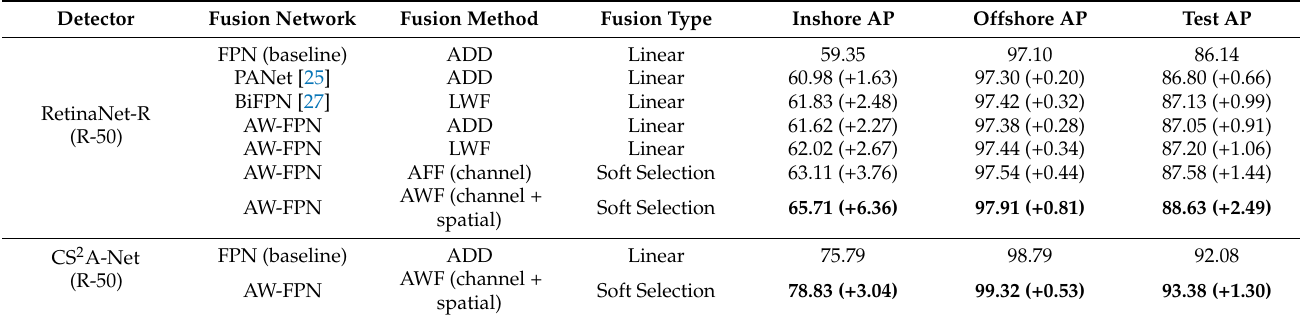
Table 8. Comparison of different feature fusion networks on SSDD.